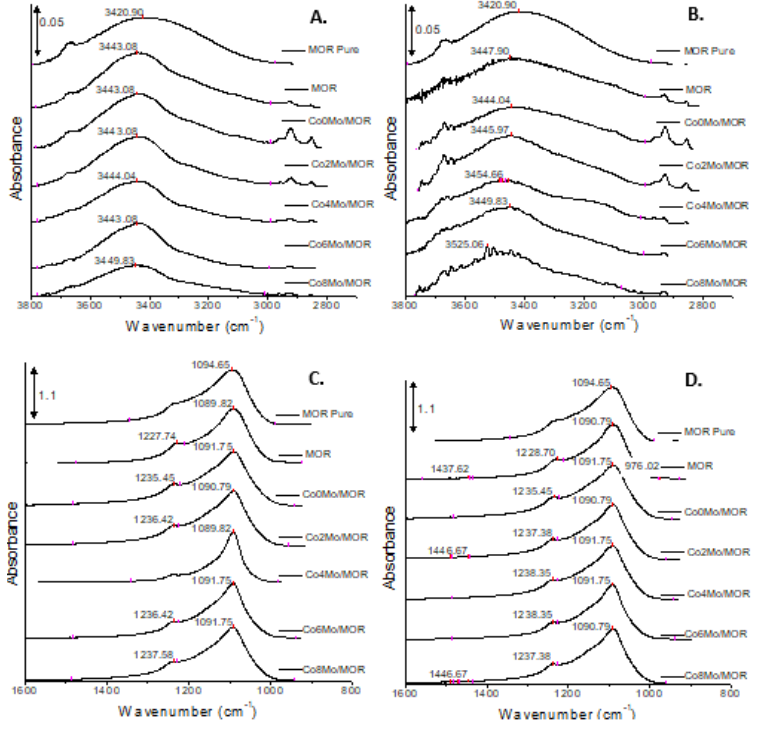
Figure 6: FTIR spectra after pyridine adsorption, (A) & (C) after evacuated at room temperature; (B) & (D) at 150 o